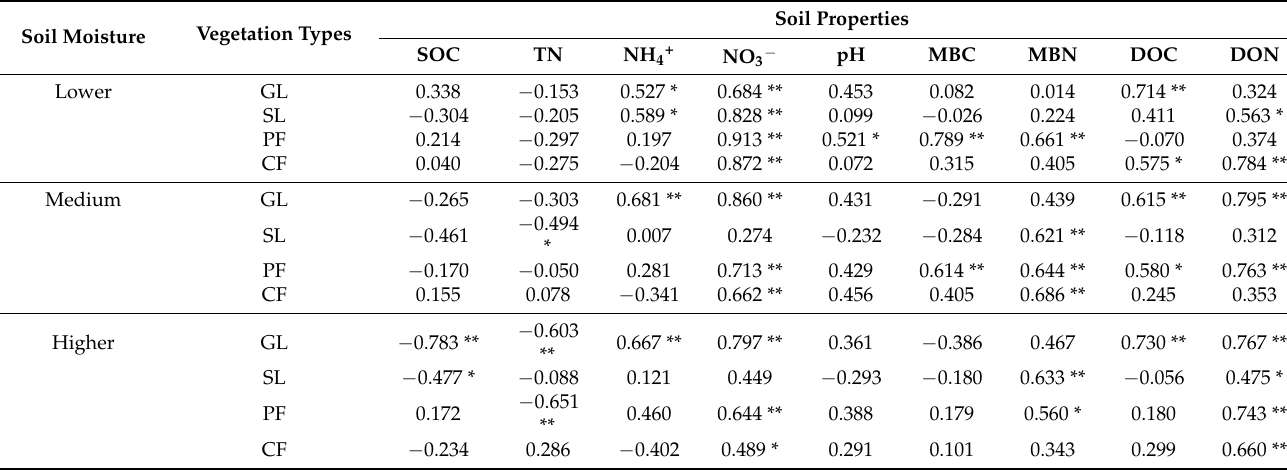
Table 3. Correlation coefficient between litter decomposition rate and soil physico-chemical properties under the influence of vegetation type and soil moisture. Soil Moisture